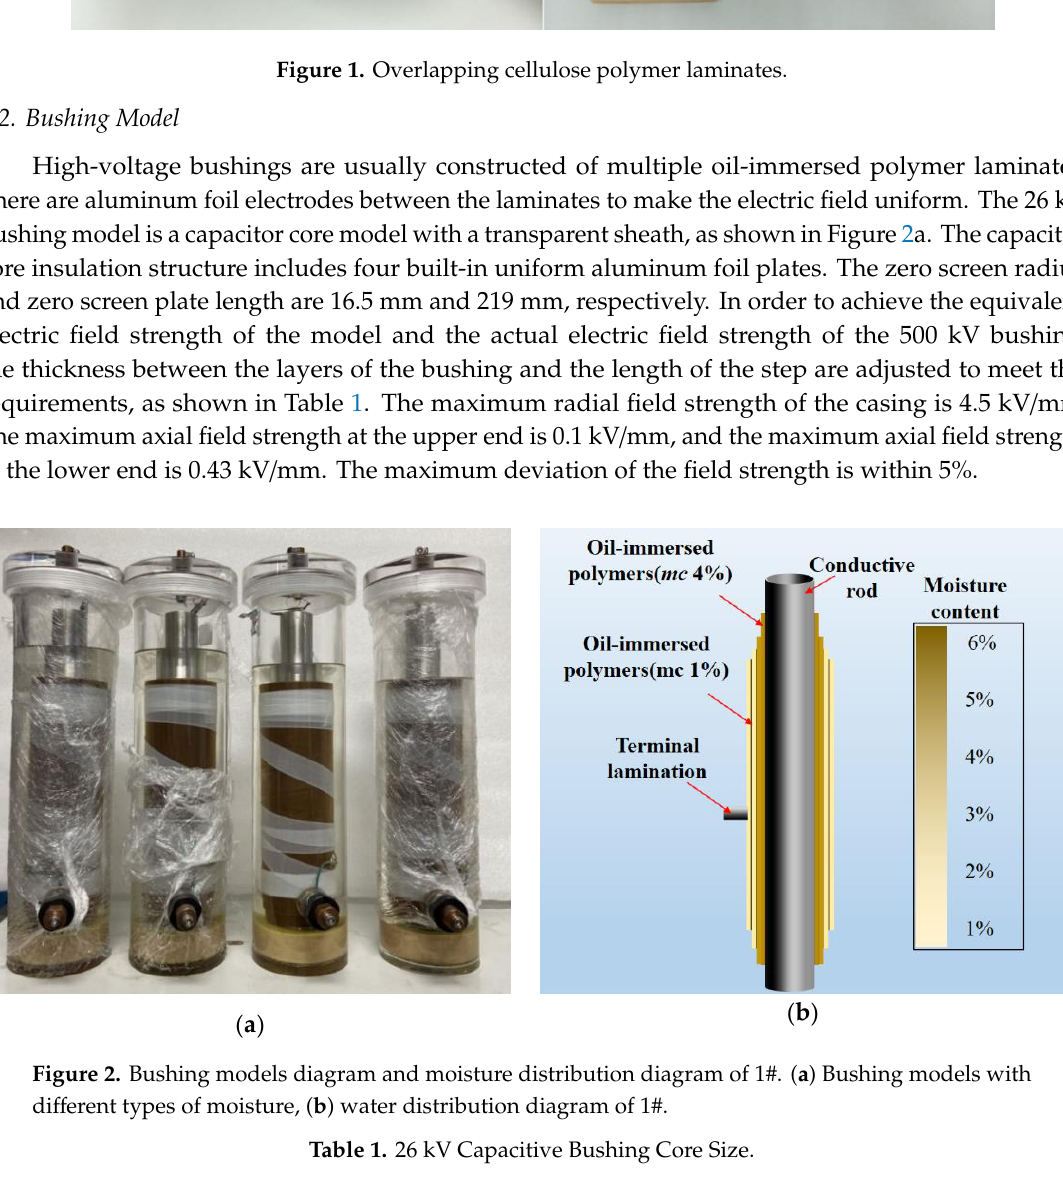
Table 2. Radial moisture distribution of oil-polymer insulated bushing model. Figure 2. Bushing models diagram and moisture distribution diagram of 1#. ( a ) Bushing models with different types of moisture, ( b ) water distribution diagram of 1#. Table 1. 26 kV Capacitive Bushing Core